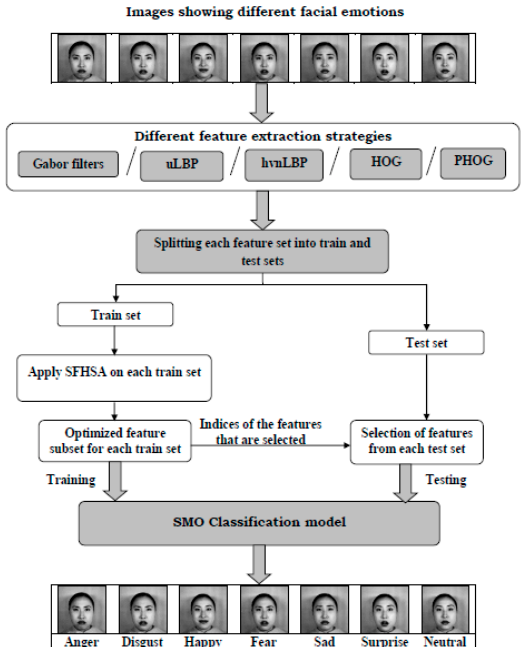
Figure 6. Schematic diagram of the proposed feature selection model called SFHSA developed for classification of facial emotions.